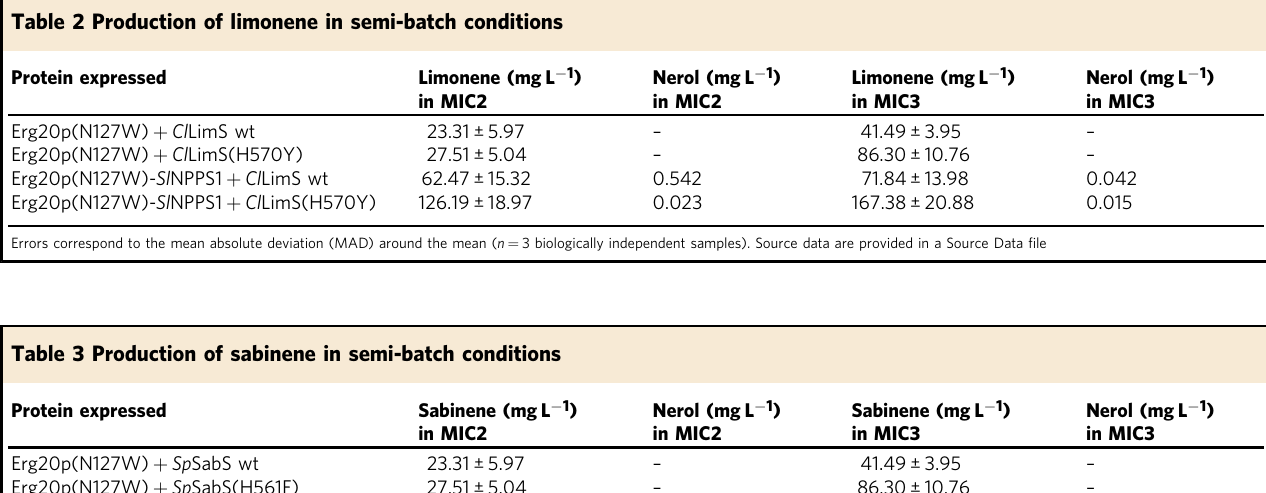
Table 2 Production of limonene in semi-batch conditions Protein expressed